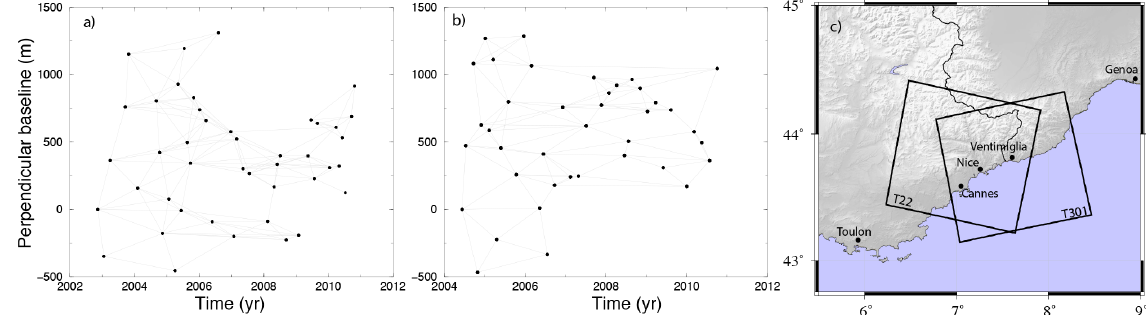
Figure 2. Relative position of Envisat orbits plotted as a function of image acquisition date for (a) ascending track 301 and (b) descending track 22. Grey lines show the interferograms included in the time series analysis. (c) Spatial coverage of tracks 301 and 22 are represented by the black